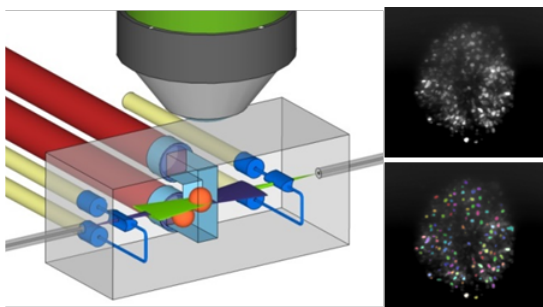
Fig. 1. Schematic of a dual-colour optofluidic selective plane illumination microscope on chip. An example of maximum intensity projection image of a tumour spheroid is shown on the right along with a segmentation of the image where the nuclei of cells are highlighted with different